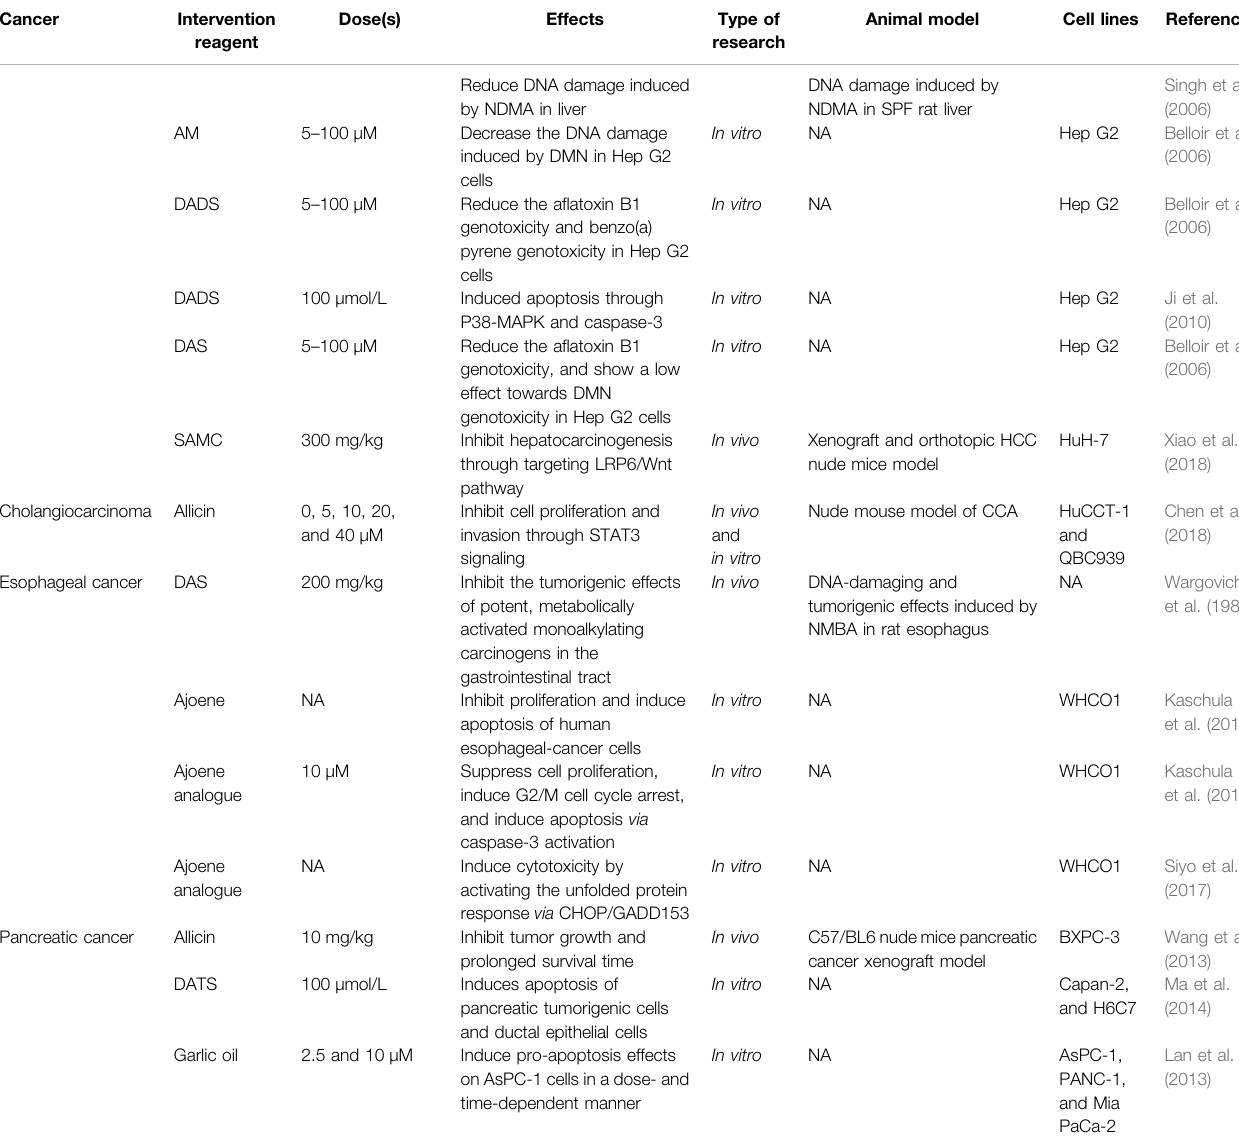
TABLE 1 | ( Continued ) Summary of mechanisms of allicin and its secondary metabolites against cancers of digestive system.